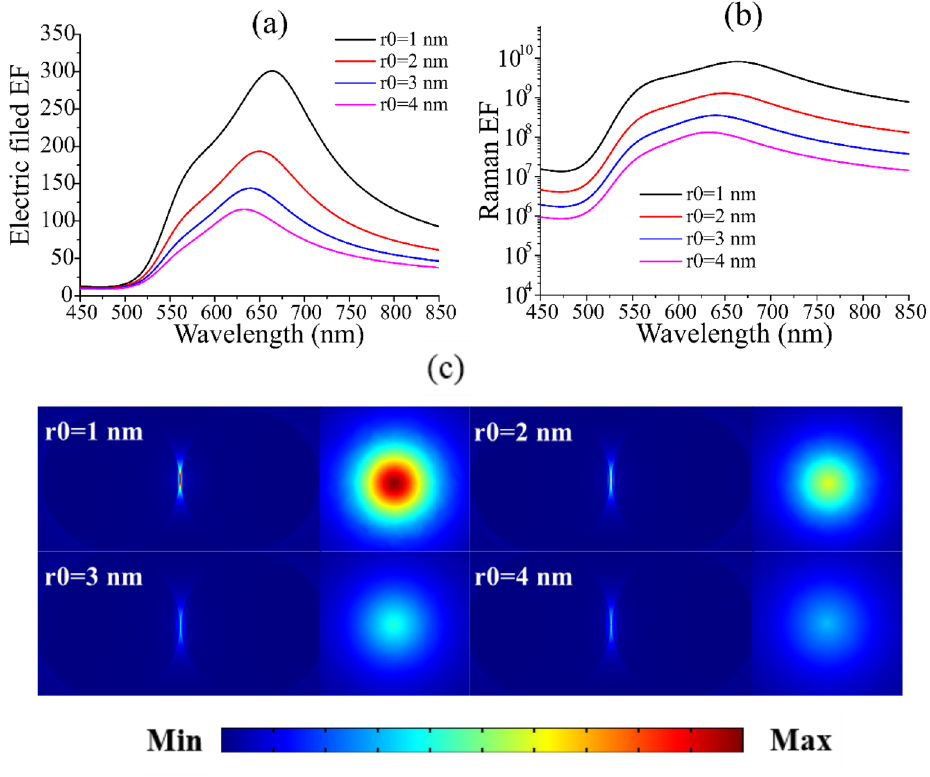
Figure 5. The relation curve of electric field enhancement ( a ) and Raman enhancement factor ( b ) covering different Al 2 O 3 thickness with the change of incident light wavelength. ( c ) Is the side view and top view of electric field distribution with different thickness Al 2 O 3 (r 0 = 1 ~ 4 nm). The excitation wavelength of the Raman enhancement factor and the electric field distribution diagram are both 665 nm. The distance between Au@ Al 2 O 3 dimer is fixed at 1 nm, and the radius R is set to 50